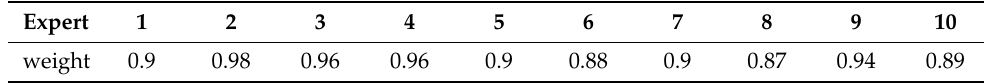
Table 2. Weight grading table of B i relative to